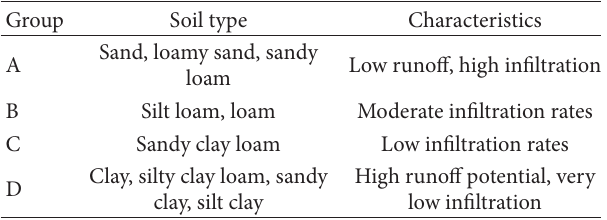
Table 1: Hydrologic soil